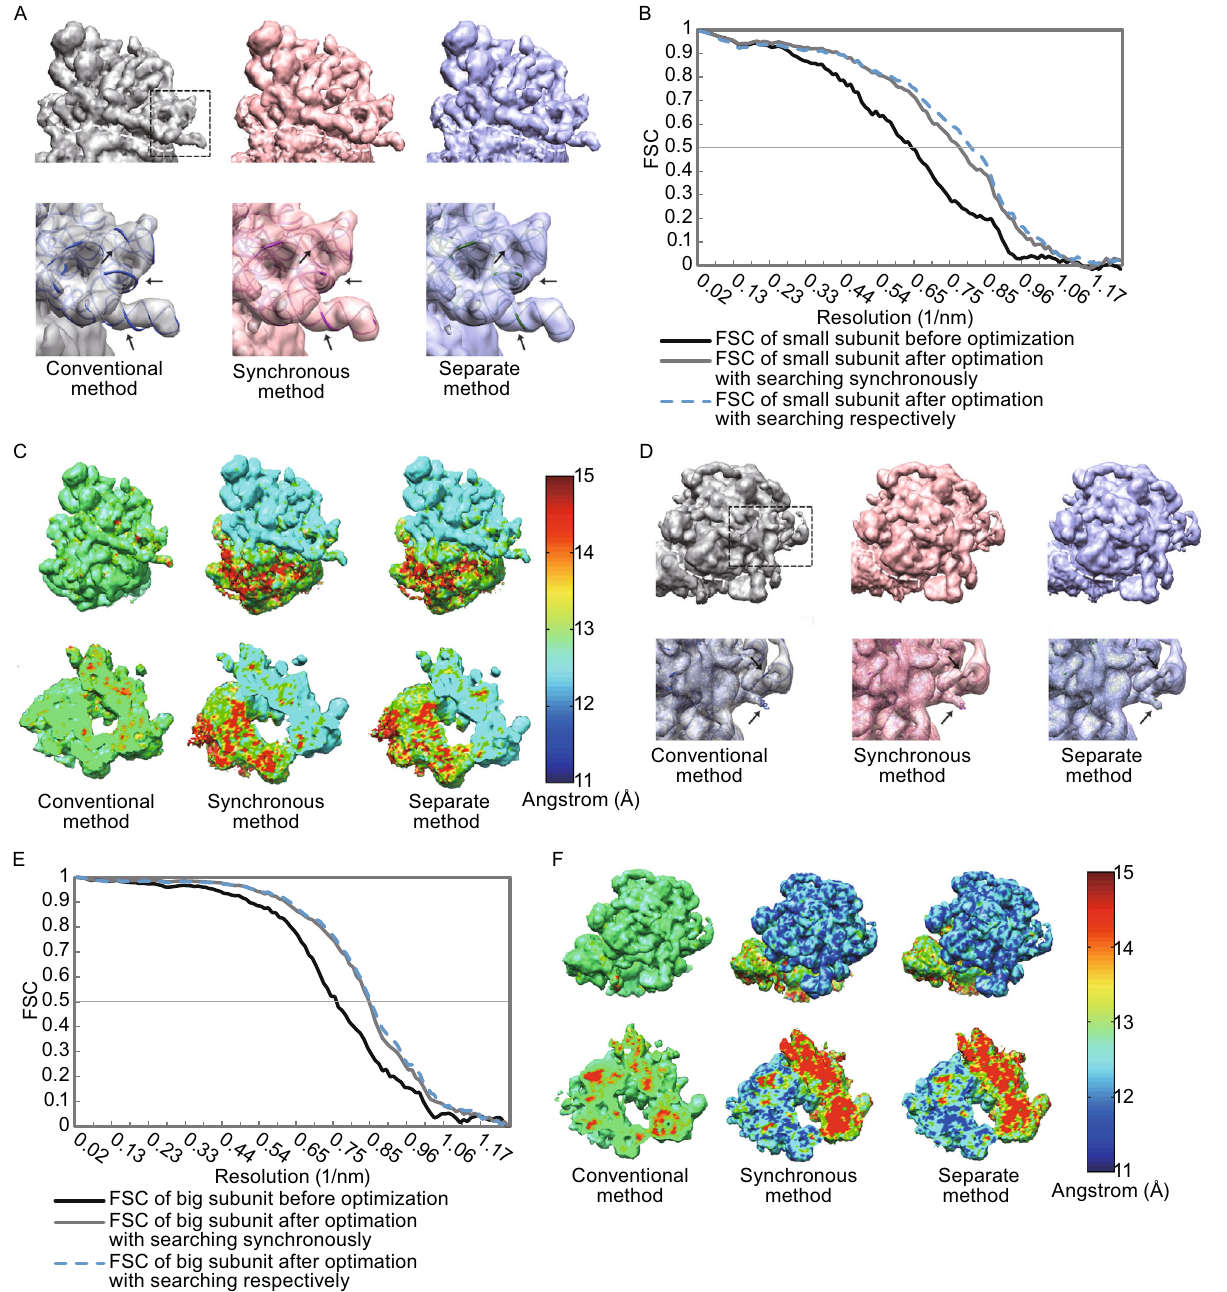
Figure 6. The improvement by the LO-re fi nement procedure for the dataset with Gaussian noise of SNR = 0.11. The scenario is same as that in Fig. 5. In brief, (A) and (D) are the comparisons of reconstructions for small subunits (A) and large subunits (D). (B) and (E) are the corresponding FSC curves respectively. (C) and (F) are the local resolution analyzes of the reconstructed density maps. For detailed descriptions, see Fig.